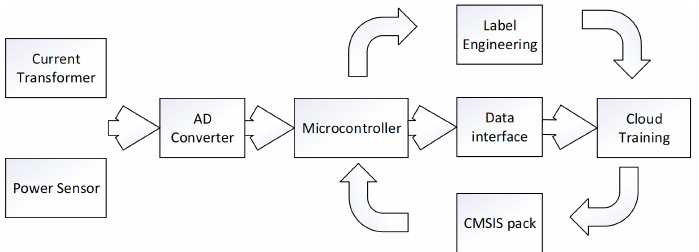
Figure 3. The procedure of implementing the deepEdge appliance identification